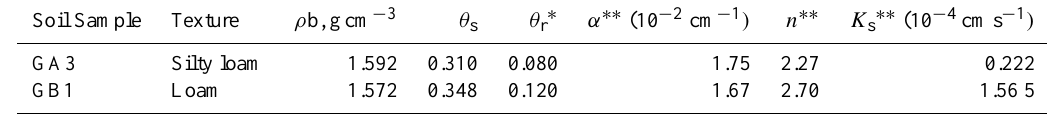
Table 1. Physical and soil hydraulic properties of the two soil samples employed for the evaporation experiments. Soil Sample Texture